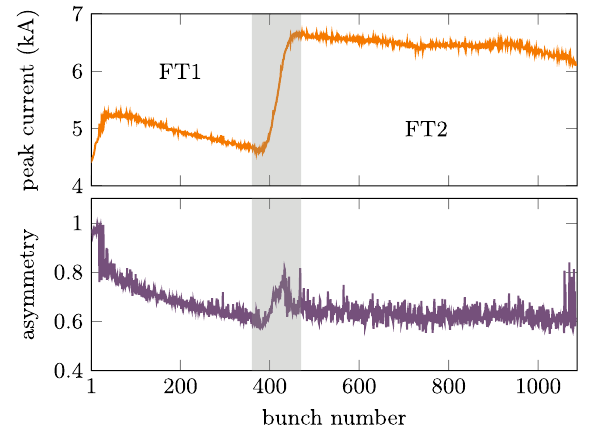
FIG. 11. Form factors measured simultaneously to FEL oper- ation with two rf flat-tops (FT1, FT2). One bunch from each rf flat-top is shown with its bunch index quoted in the legend. The inset shows the corresponding reconstructed current profiles.